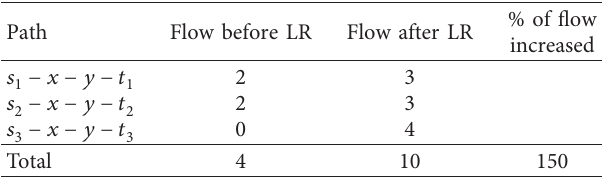
Figure 2: Network with (a) flow, capacity and (b) flow with saved capacity on the arcs. Table 1: Maximum multicommodity flow before and after lane